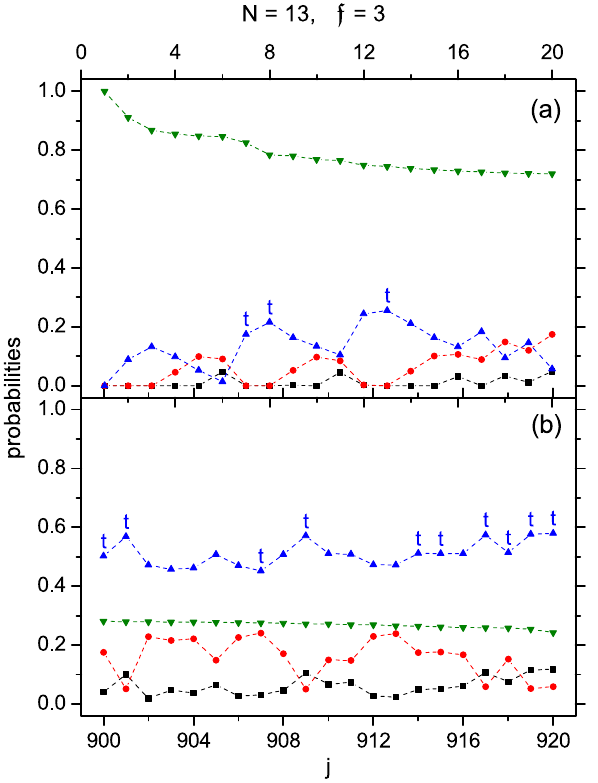
Figure 4. P (cid:31) against j for the case of H (cid:31) with N = 13 and f = 3 (refer to Fig.